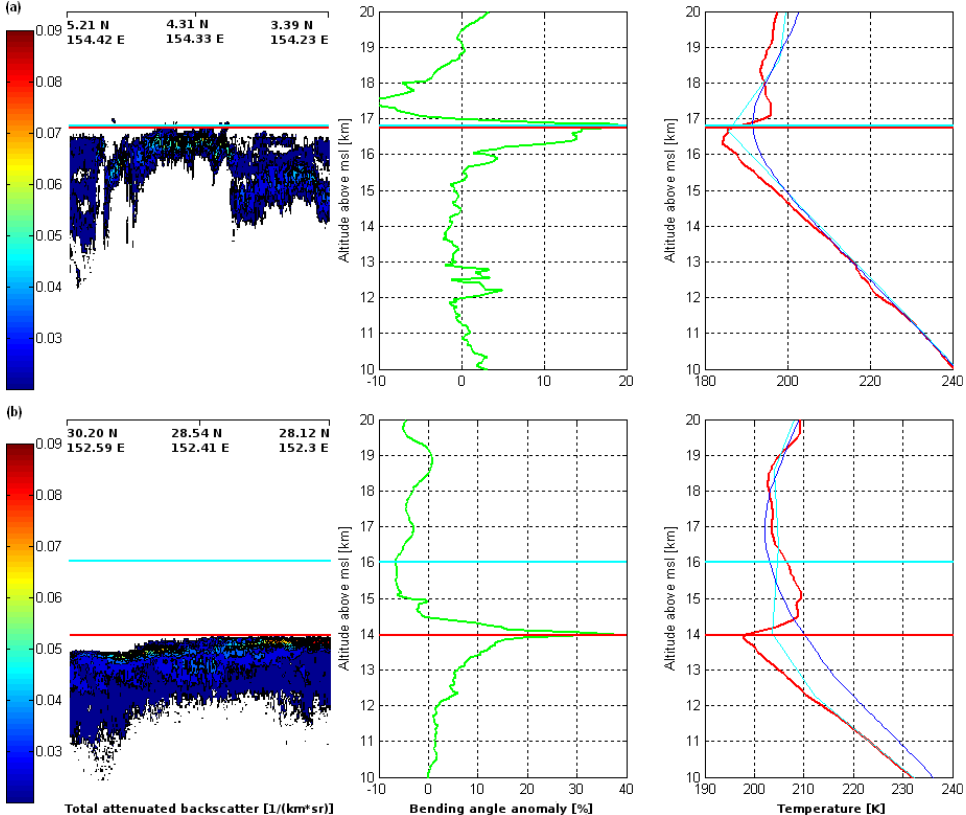
Fig. 4. Two examples of convective systems reaching different altitude: 22 January 2008 at 14:58:00UTC (top panel) and 14 April 2008 at 17:07:00UTC (bottom panel). The left panels show the total attenuated backscatter at 532nm from CALIOP (at 15:28:00UTC and 15:54:00UTC, respectively), and the right panels show the bending angle anomaly profile (green), the temperature profile from GPS RO during the storm (red), the temperature profile from ECMWF analysis (cyan) and the climatological temperature profile (blue). The horizontal cyan line is the altitude of the standard tropopause and the horizontal red line is the altitude of the coldest point and the bending angle anomaly